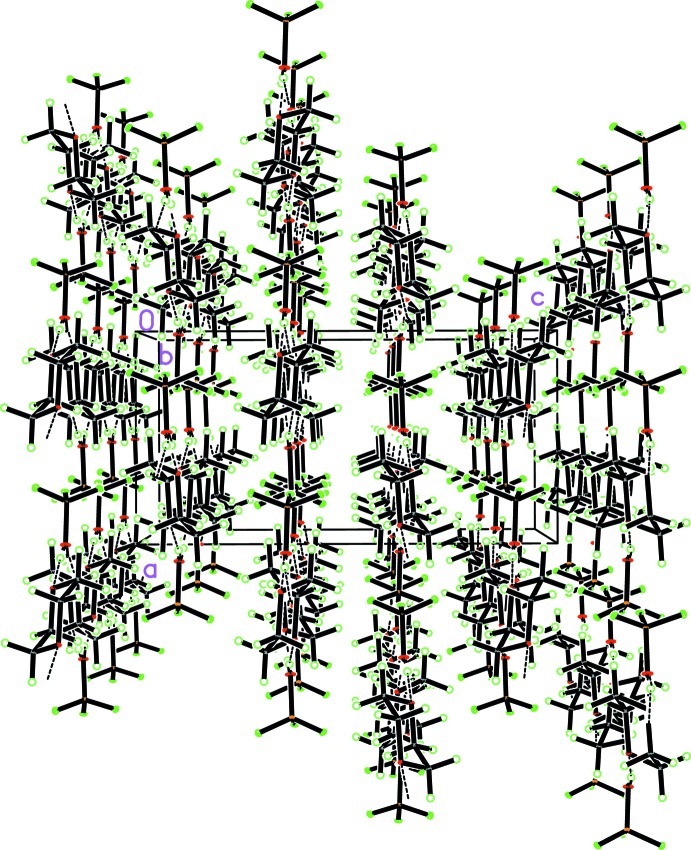
Packing diagram of 1 (view direction [010]) documenting the arrangement of the zigzag chains to flat sheets perpendicular to the c axis. Inspection of the inter­molecular distances gives no evidence for inter­actions stronger than van der Waals forces between the chains.